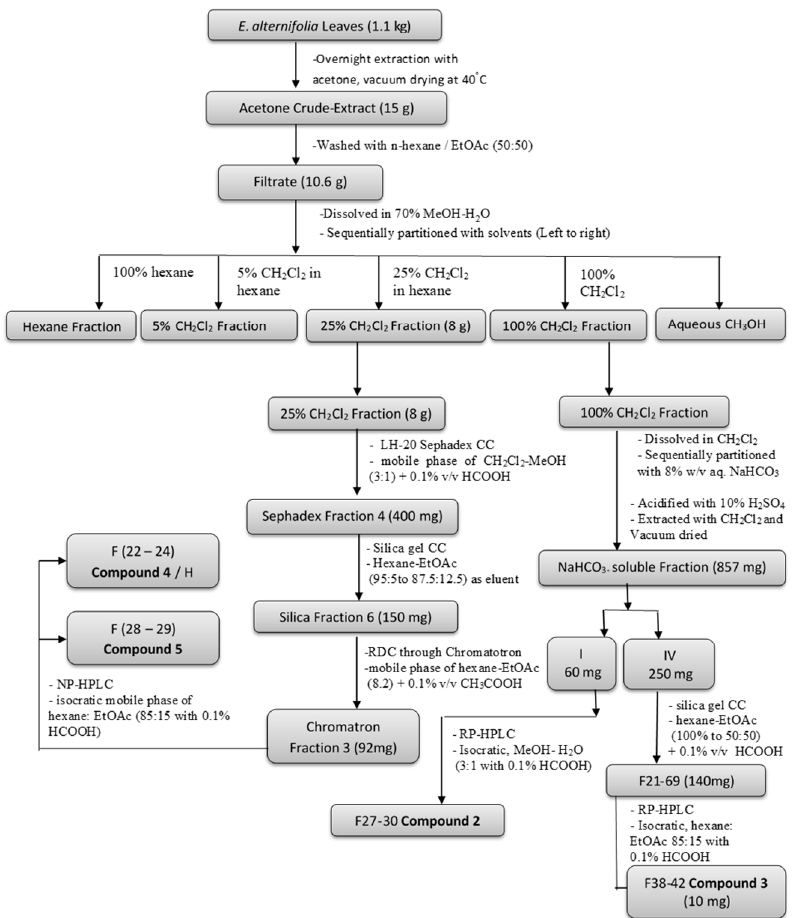
Figure 3. Flow diagram of the compound isolation process from the crude extract of E. alternifolia. The structures of the numbered compounds are given in Figure